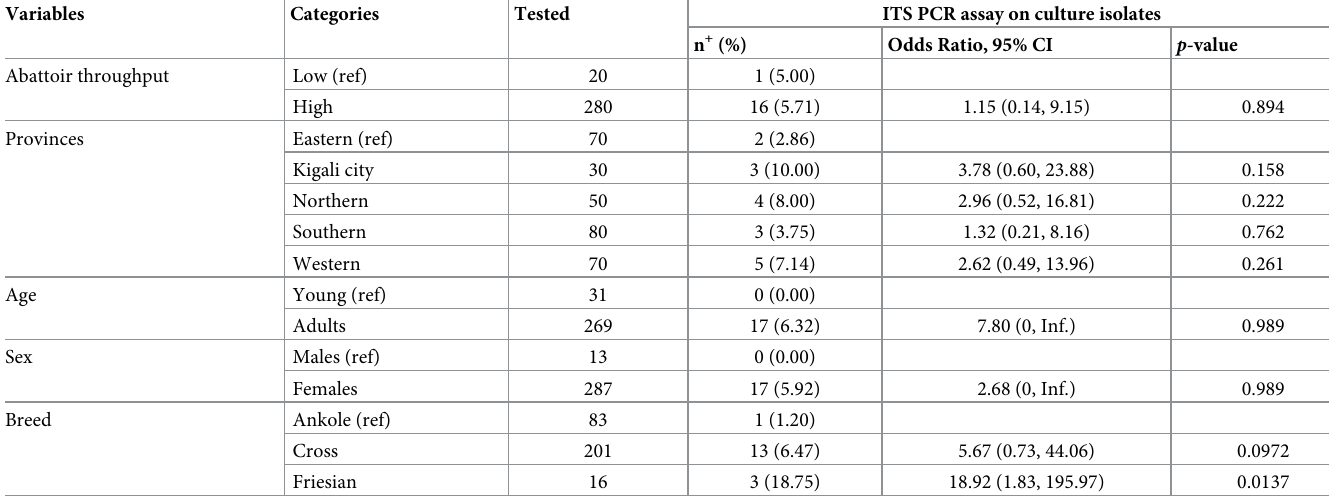
Table 3. Univariable associations between animal characteristics and ITS PCR assay of Brucella spp. isolates from cultures of tissues of slaughtered cattle in Rwanda. Variables